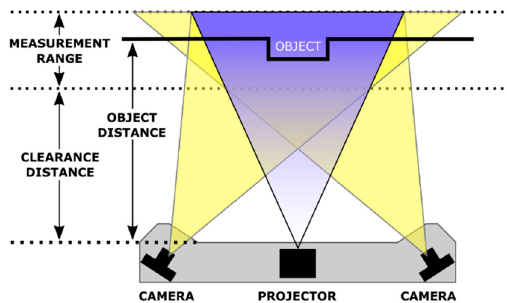
Figure 9. Blue LED sensor components.